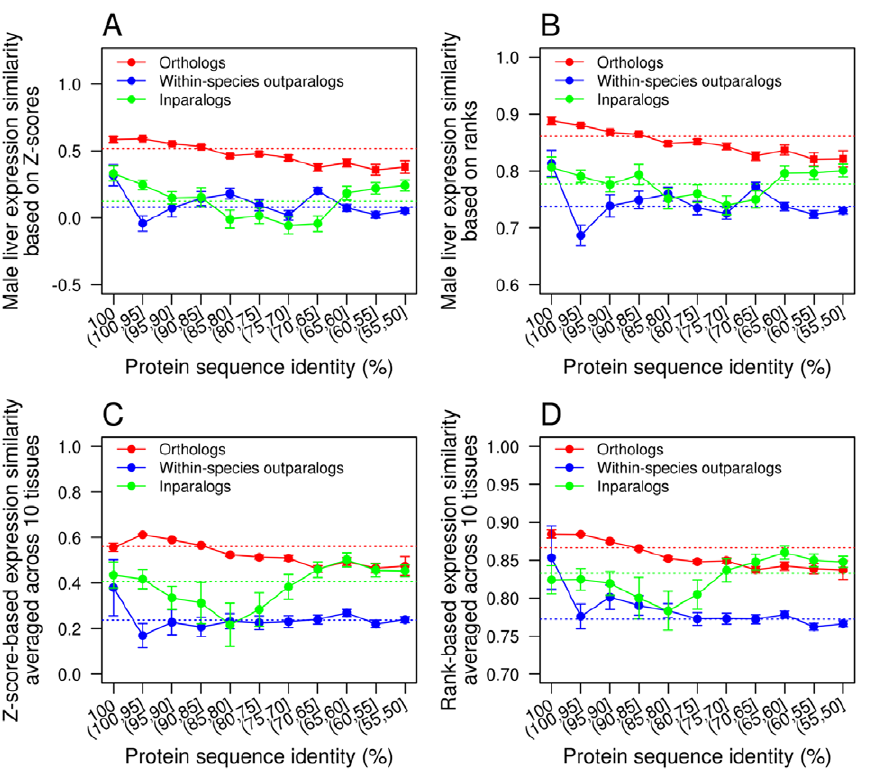
Figure 3. Expression similarity of homologous genes. ( A ) Male liver expression similarity based on expression Z -scores. ( B ) Male liver expression similarity based on expression ranks. ( C ) Mean expression similarity of 10 tissues based on expression Z -scores. ( D ) Mean expression similarity of 10 tissues based on expression ranks. Error bars show one standard error. Each solid line connects the expression similarity values of different bins, whereas the dotted line shows the mean value across all genes in all bins. In each panel, the red dotted line is significantly higher than the green line ( P , 10 2 10 , two-tail Z -test), which is in turn significantly higher than the blue line ( P , 10 2 10 , two-tail Z -test).